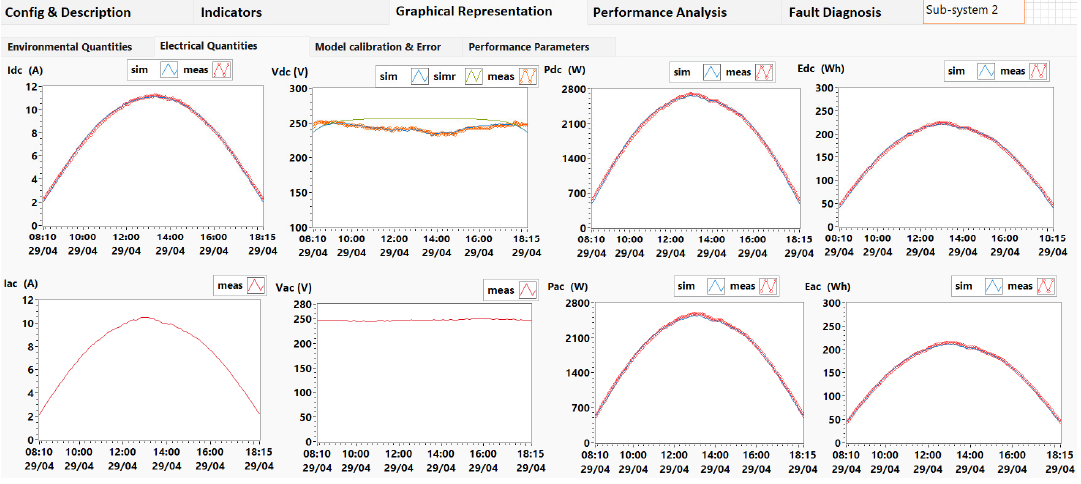
Figure 17. Measurement graphs of both measured and predicted DC and AC electrical quantities.